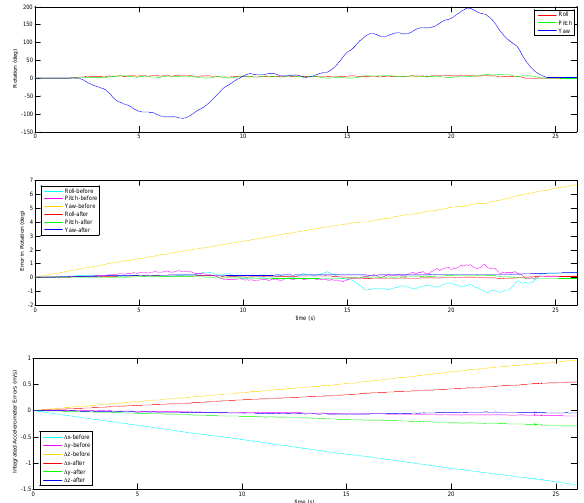
Figure 4: (Top) the reference orientation of the walking trial (with the IMU near the torso) determined by iMAR; (Middle) orientation errors from integrating the gyroscope signal; (Bottom) accelerometer errors from integrating the accelerometer signal in a rotating frame before and after in-situ self-calibration with CUPT.